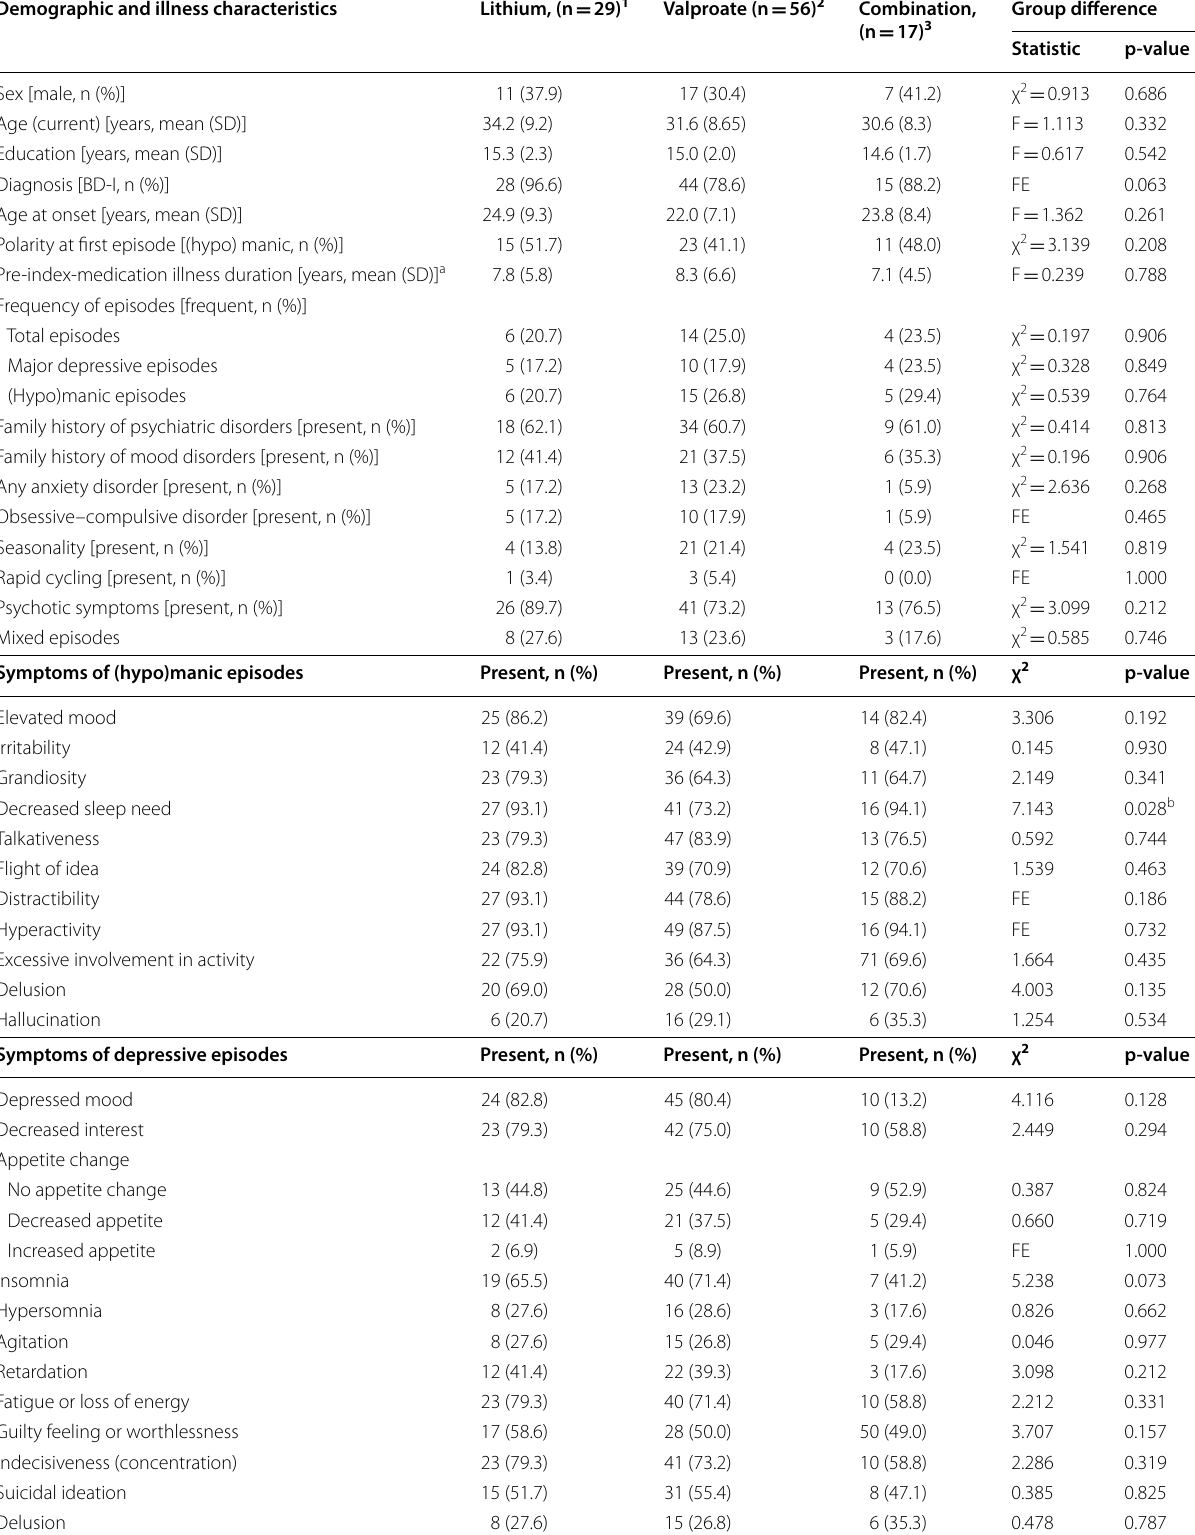
Table 1 Comparison of baseline characteristics between medication groups Demographic and illness